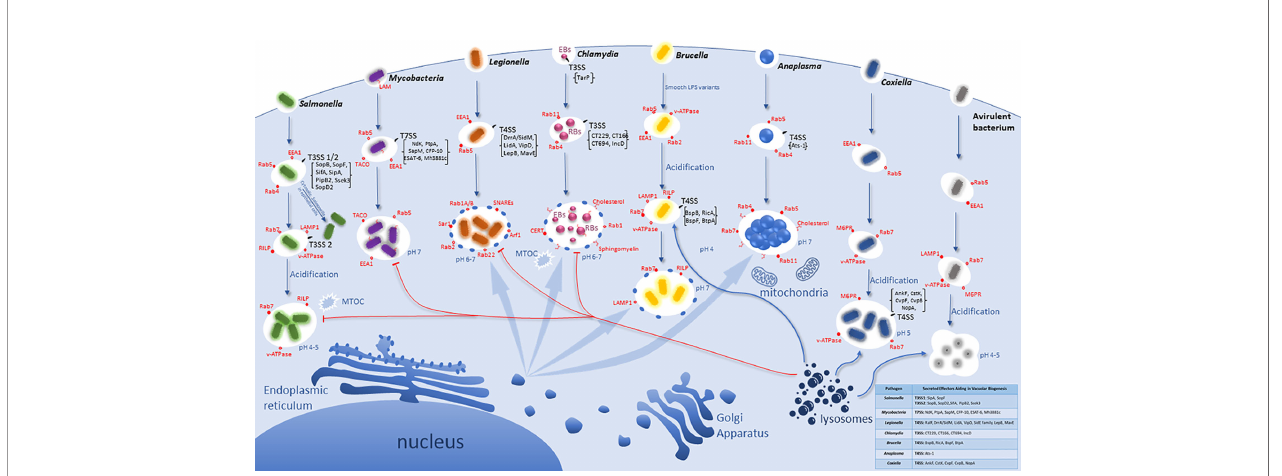
FIGURE 1 | Idiosyncratic Biogenesis of the Vacuoles harboring Intracellular bacterial Pathogens. Pathogens have evolved distinct pathogenic factors and biochemical mechanisms to evade degradation upon entering host cells and enable their proliferation within modi fi ed vacuoles. All the listed pathogens have evolved specialized secretion machineries (Type 3 - Type 7) that inject effector proteins into the host cytosol to interact and modulate speci fi c host cell proteins and/or processes. However, the T4SS of Coxiella is not functional until vacuolar acidi fi cation and is speci fi cally used in replication but may not be involved in vacuole biogenesis. These seven intra-vacuolar bacterial pathogens, Salmonella, Mycobacteria, Legionella, Chlamydia, Brucella, Anaplasma , and Coxiella , interfere with endocytic, exocytic and/or ER-to-Golgi vesicle traf fi cking to evade lysosomal degradation. Salmonella and Coxiella proliferate within an acidi fi ed late endosome/ lysosomal-like vacuole whereas Legionella, Chlamydia , Anaplasma as well as Brucella intercept and modulate ER-to Golgi vesicles for their vacuole